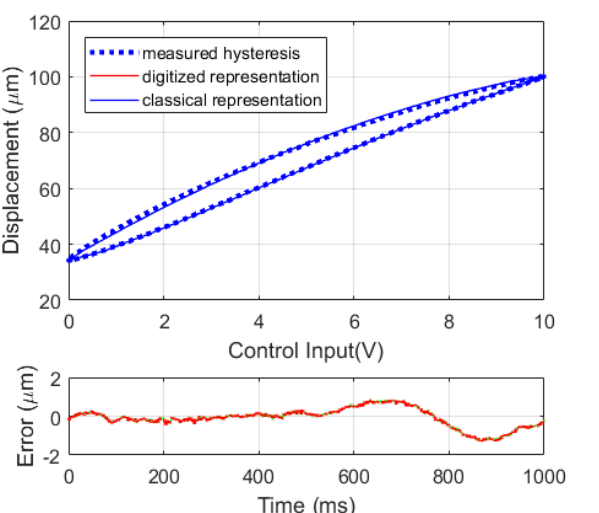
Figure 9. Modeling results using the classical representation and the digitized representation with dead-zone operators at 1 Hz, sinusoidal